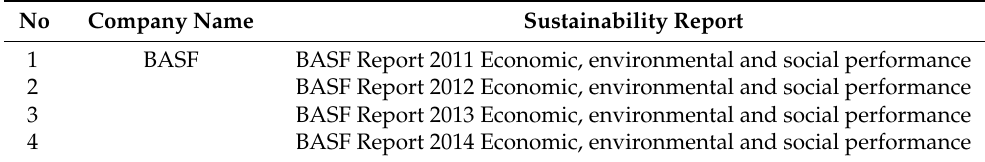
Table A2. List of Corporate Sustainability Reports from 2011 to